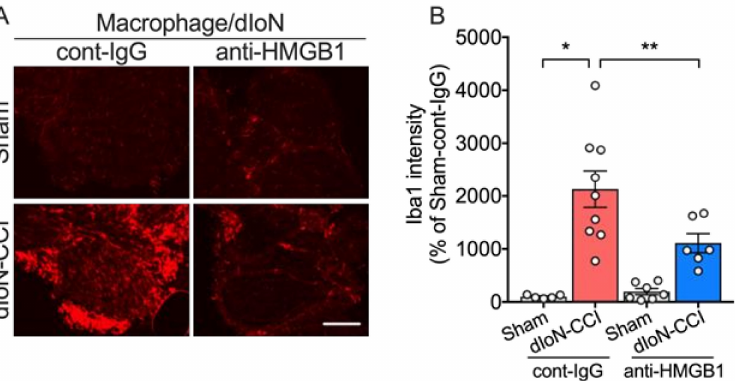
Figure 6. Effect of neutralizing antibody HMGB1 (anti-HMGB1 nAb) on macrophage accumulation in sham and dIoN-CCI mice. ( A ) Fluorescent photomicrographs of Iba1, a macrophage marker, of IoN from sham and dIoN-CCI mice 14 days following surgery. ( B ) Mean Iba1 intensity ( n = 5–9 mice). One section was taken from one mouse on Day 3 and Day 7. One section was taken from seven mice on Day 14. Scale bar = 50 µ m. Data are expressed as individual and mean ± SEM. * p < 0.05, ** p < 0.01 (two-way ANOVA followed by Sidak’s correction for multiple comparisons).